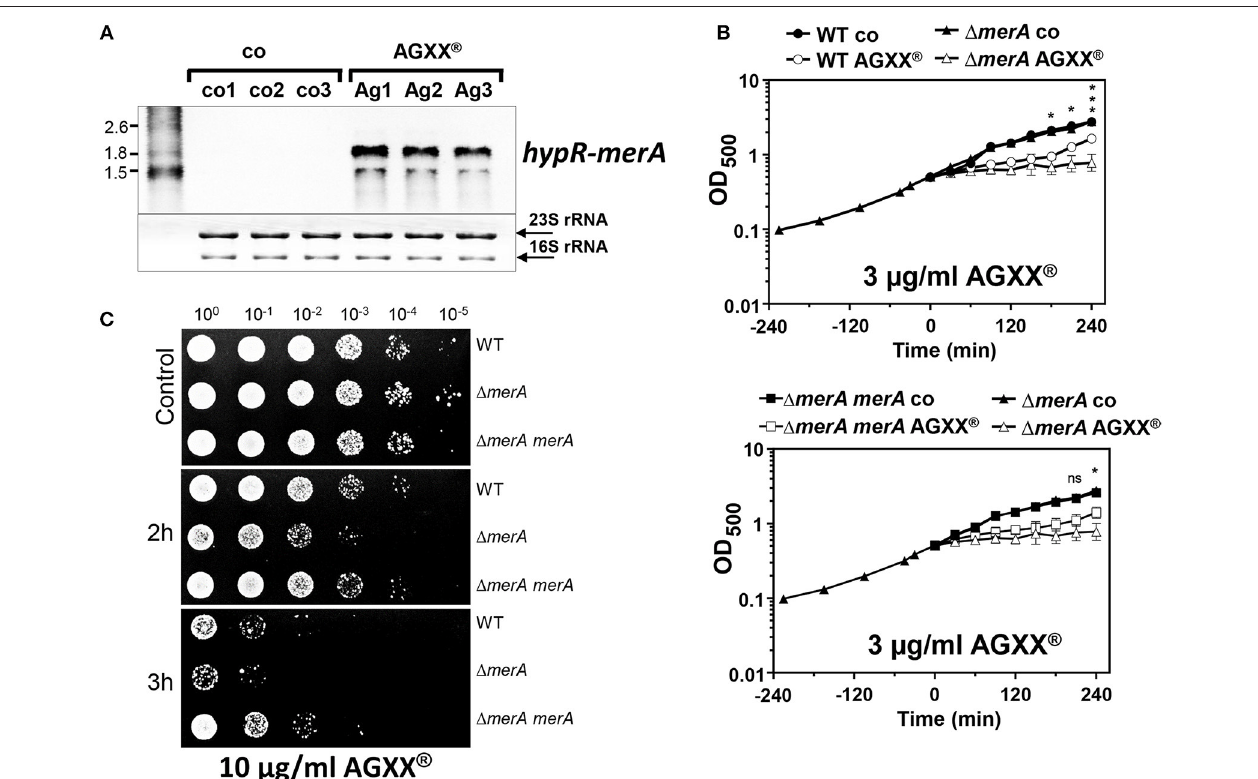
FIGURE 6 | The NADPH-dependent disulfide reductase MerA is strongly induced and required for growth and survival under AGXX ® stress in S. aureus . (A) Northern blot analysis was performed for hypR-merA operon transcription in S. aureus USA300 wild type before (Co1-3) and 30min after exposure to 4.5 µ g/ml AGXX ® (Ag1-3). The RNA samples 1–3 correspond to 3 biological replicates. The methylene blue bands denote the 16S and 23S rRNAs as RNA loading controls below the Northern blots. (B) The growth curves were compared for the S. aureus COL wild type (WT), the merA deletion mutant and the merA complemented strain in RPMI medium before (control) and after treatment with 3 µ g/ml AGXX ® . The time point before AGXX ® exposure was set to “0.” Results of three biological replicates are presented as mean values. Error bars represent the SD and the statistics was calculated using a Student’s unpaired two-tailed t -test by the graph prism software. Symbols are defined as follows: ns p > 0.05; * p ≤ 0.05 and *** p ≤ 0.001. (C) Survival was analyzed for S. aureus COL wild-type (WT), the merA mutant and the complemented strain after exposure to 10 µ g/ml AGXX ® in RPMI medium. Survival assays were performed by spotting 10 µ l of serial dilutions after 2 and 3h of AGXX ® exposure onto LB agar plates. Three biological replicate experiments were performed and one representative survival experiment is shown.